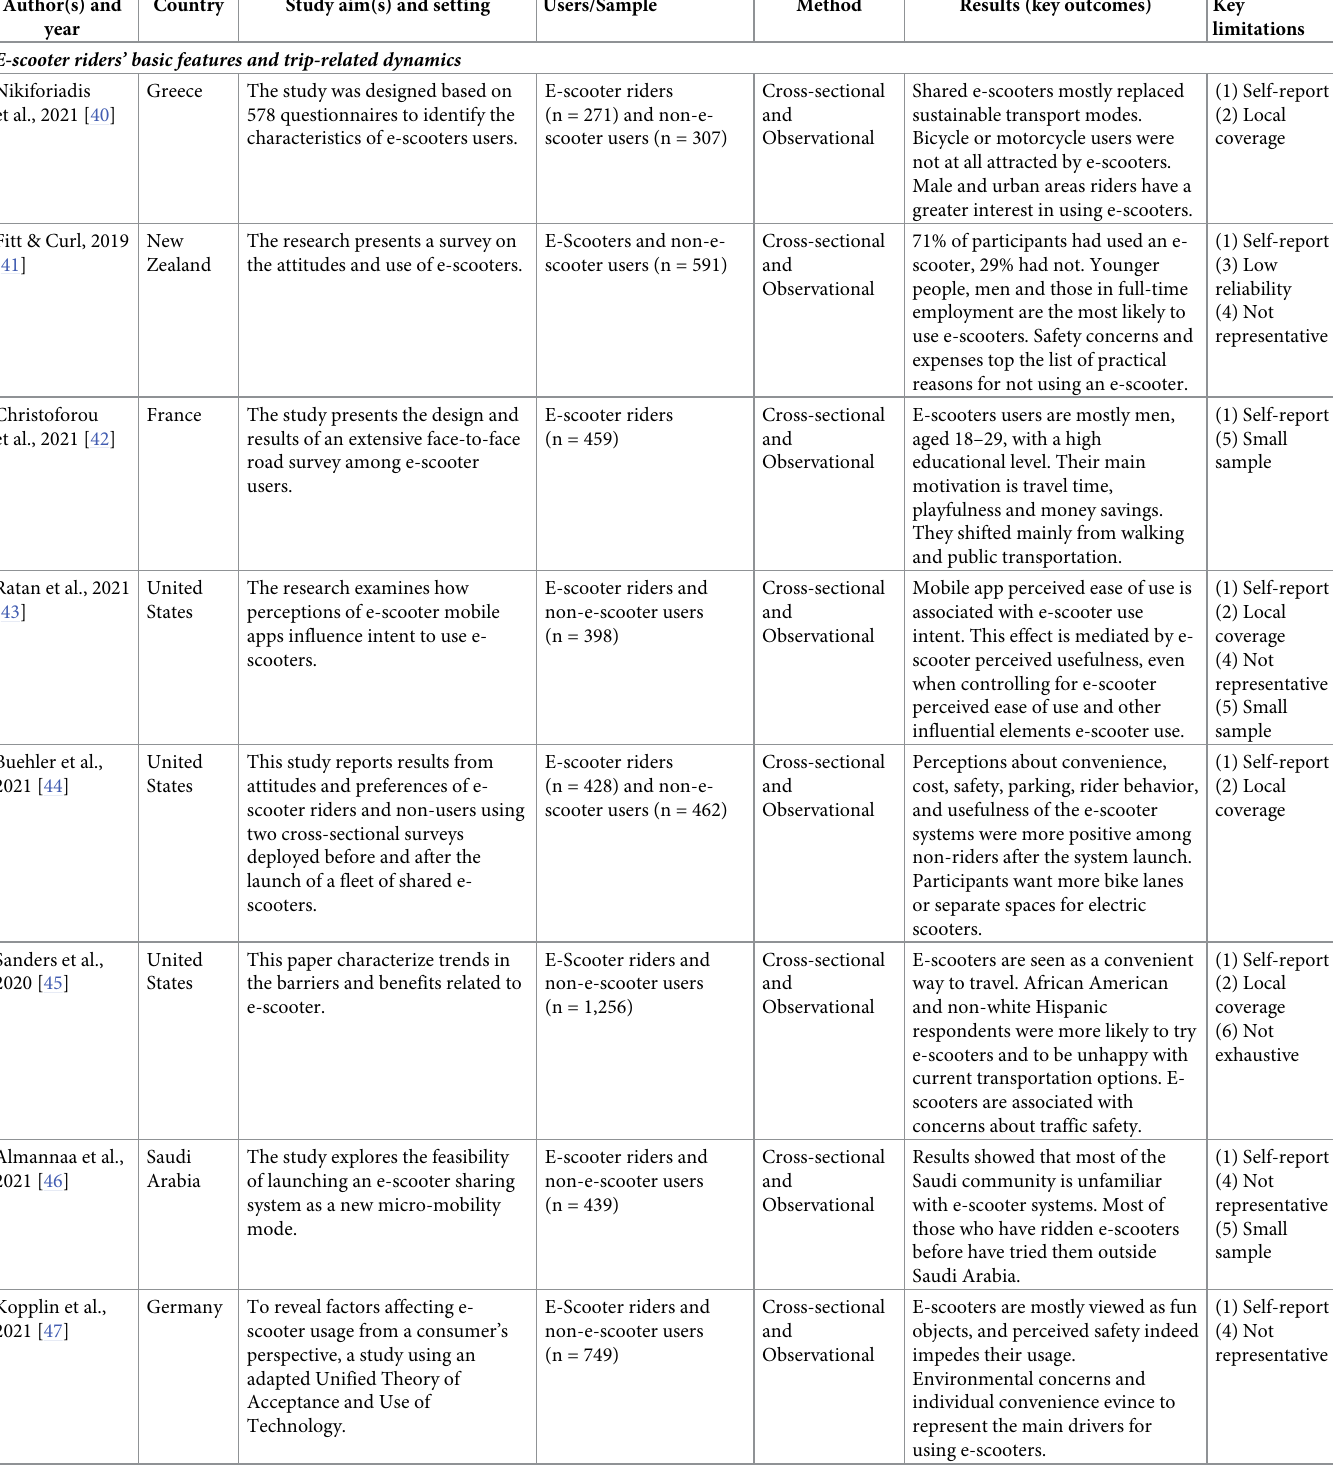
Table 1. Structured sescription of study setting, key outcomes and limitations of eligible